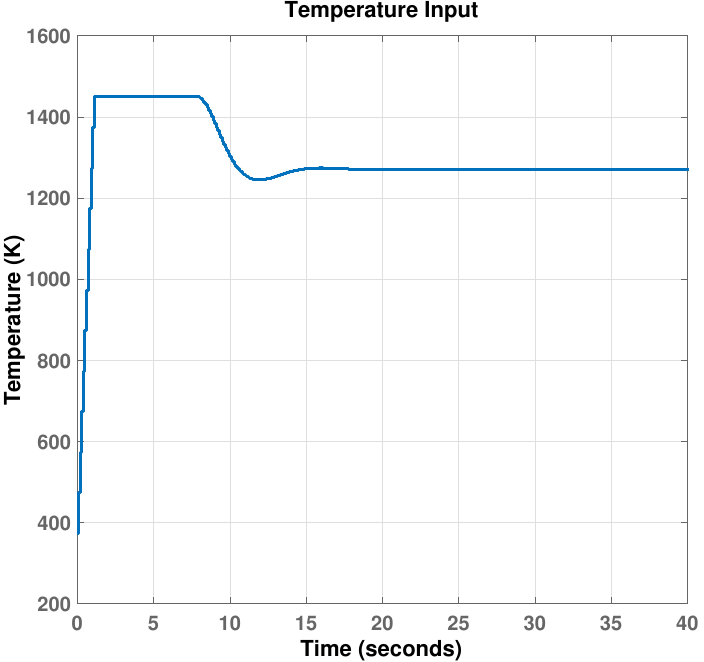
Figure 12. Controlled input